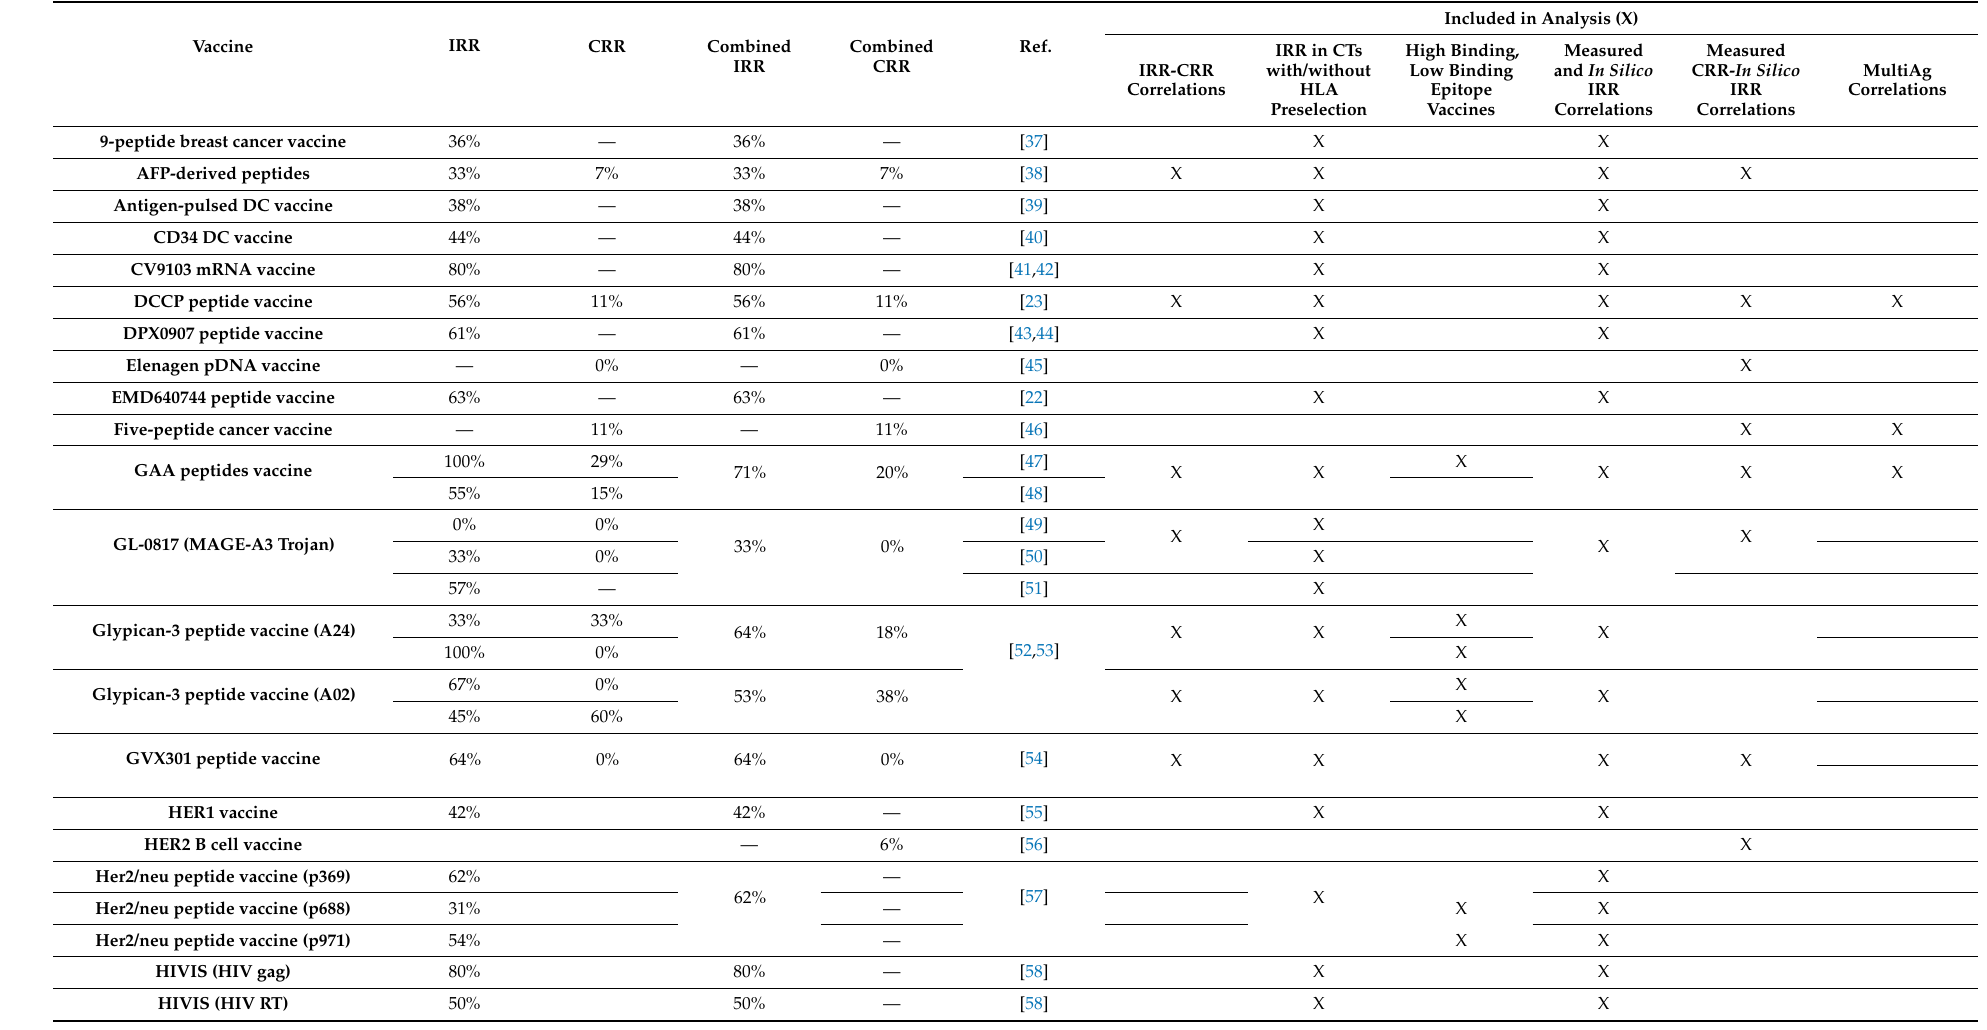
Table A1. Immune- and clinical response rates reported in the referenced studies. When the same vaccine was used in multiple trials the response rates were combined. Vaccine IRR CRR Combined